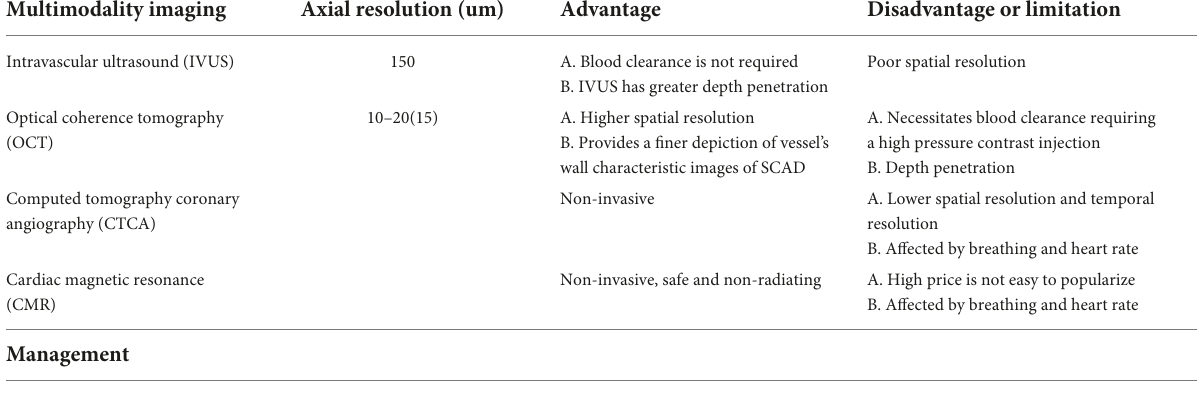
TABLE 2 Intracoronary imaging of spontaneous coronary artery dissection (SCAD) by IVUS/OCT/CT/CMR and management. Multimodality